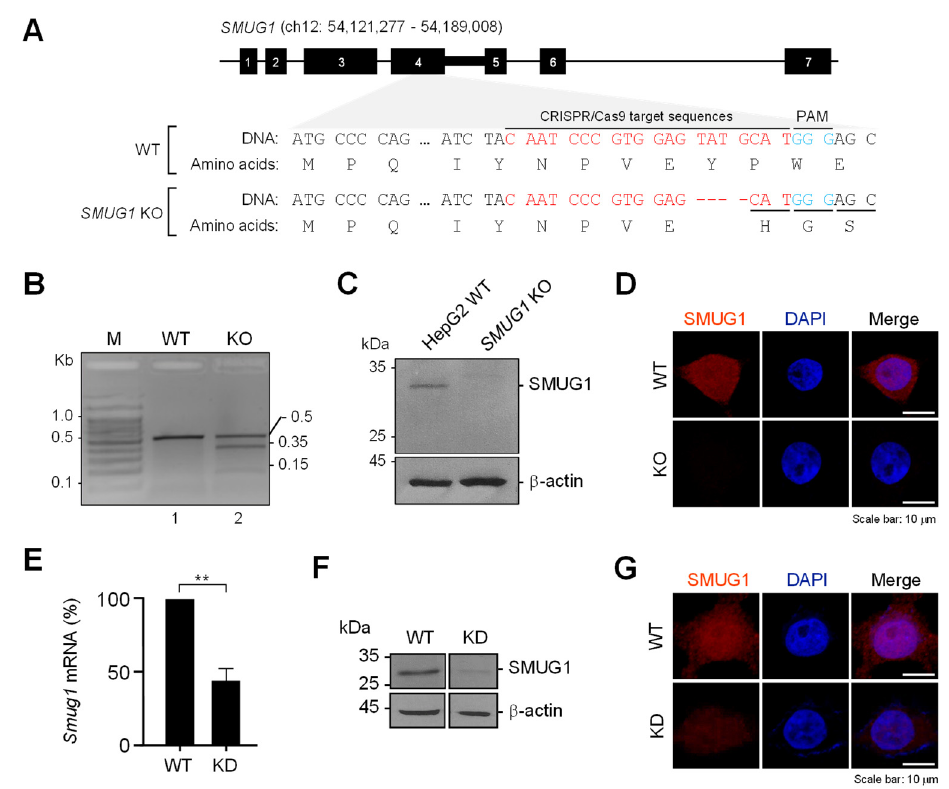
Figure 1. The construction of SMUG1 knock-out and knock-down hepatocarcinoma HepG2 cells. ( A ) Schematic diagram of the SMUG1 target sites. sgRNA-targeting sequence was located on the antisense strand of exon 4 of SMUG1 . The sgRNA-targeting sequence is in red, and the protospacer adjacent motif (PAM) sequence is in blue. ( B ) Validation of SMUG1 KO for CRISPR/Cas9 efficiency using T7E1 assay. ( C ) Knock-out of SMUG1 was confirmed by immunoblotting using an anti-SMUG1 antibody. -actin was used as an internal control. ( D ) Knock-out of SMUG1 was visualized by immunocytochemistry using an anti-SMUG1 antibody (red). The cell nuclei were stained with DAPI (blue). ( E ) Validation of SMUG1 mRNA expression by RT-qPCR. ( F ) Knock-down of SMUG1 was confirmed by immunoblotting using an anti-SMUG1 antibody. β -actin was used as an internal control. ( G ) Knock-down of SMUG1 was visualized by immunocytochemistry using an anti-SMUG1 antibody (red). The cell nuclei were stained with DAPI (blue). Error bars show mean ± SEM. p value obtained by Student’s t -test. ** p value < 0.01.